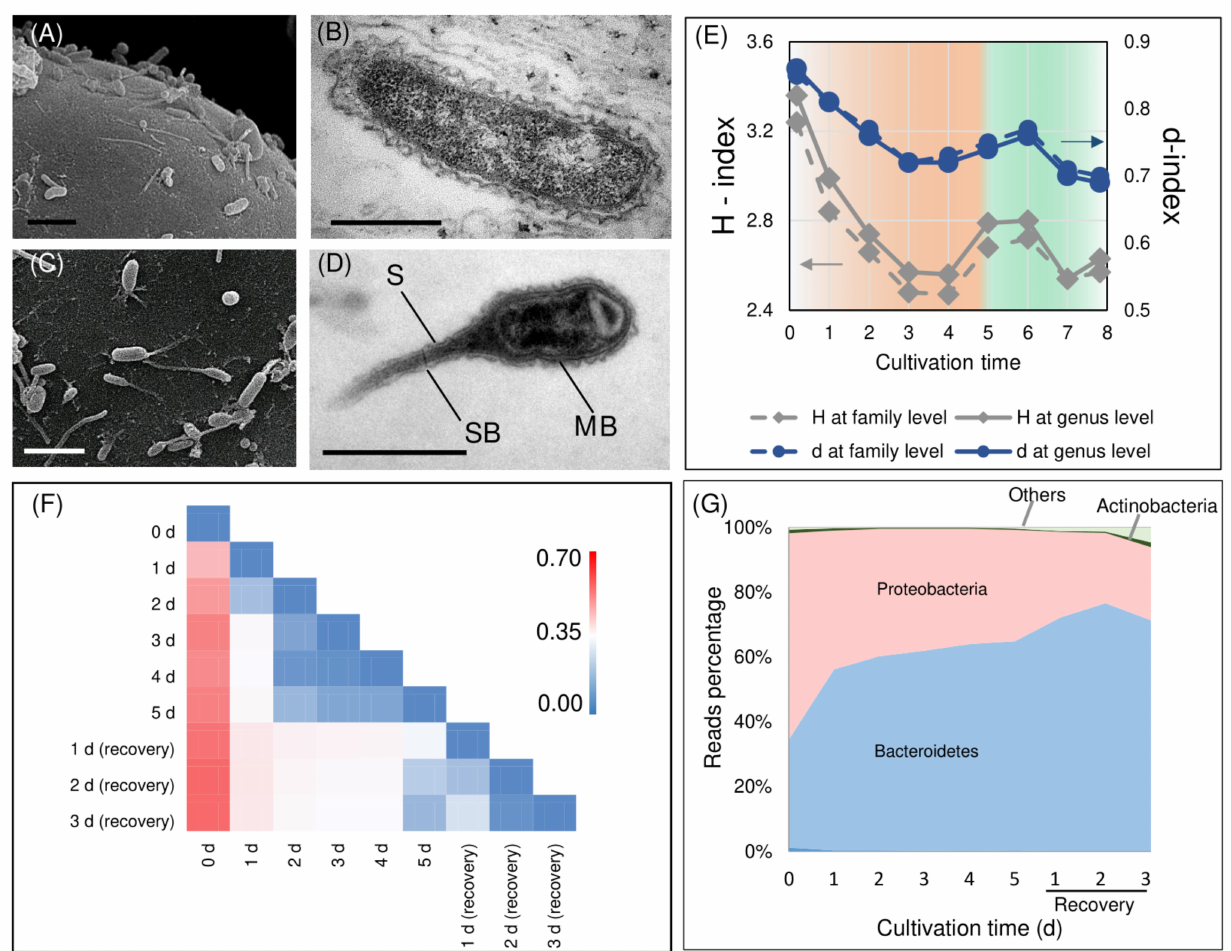
Figure 2. Attachment of bacteria to the surface of H. lacustris vegetative cells ( A ) and haematocysts ( C ). Typical rod-shaped gram-negative bacteria abundant in the suspension of H. lacustris cells cultivated in a photobioreactor under vegetative growth-promoting conditions ( B ). The Caulobacter -like bacteria abundant in the H. lacustris cell suspensions cultivated in the photobioreactor under stressful conditions ( D ); S: stalk, SB: stalk band, MB: main body of the cell. The dynamics of Shannon (grey lines, diamonds) and reverse Simpson (blue lines, circles) diversity indexes at genus (solid lines) or family (dashed lines) levels during astaxanthin accumulation and vegetative growth recovery of H. lacustris cultivated in a photobioreactor ( E ). The heatmap of the Morisita–Horn index values at the genus level reflects the similarity of the 16SrRNA gene libraries obtained for the H. lacustris bacterial association at different stages of the experiment ( F ). The dynamics of the bacterial consortium formed around the H. lacustris bacterial association at different stages of the experiment at the level of phylum ( G